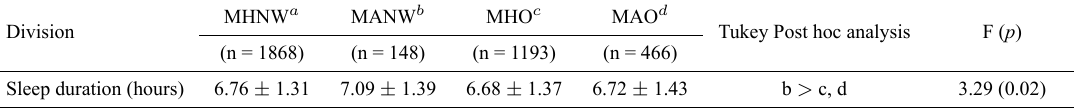
Table 3. Mean of sleep duration according to the body size phenotypes (n = 3675)